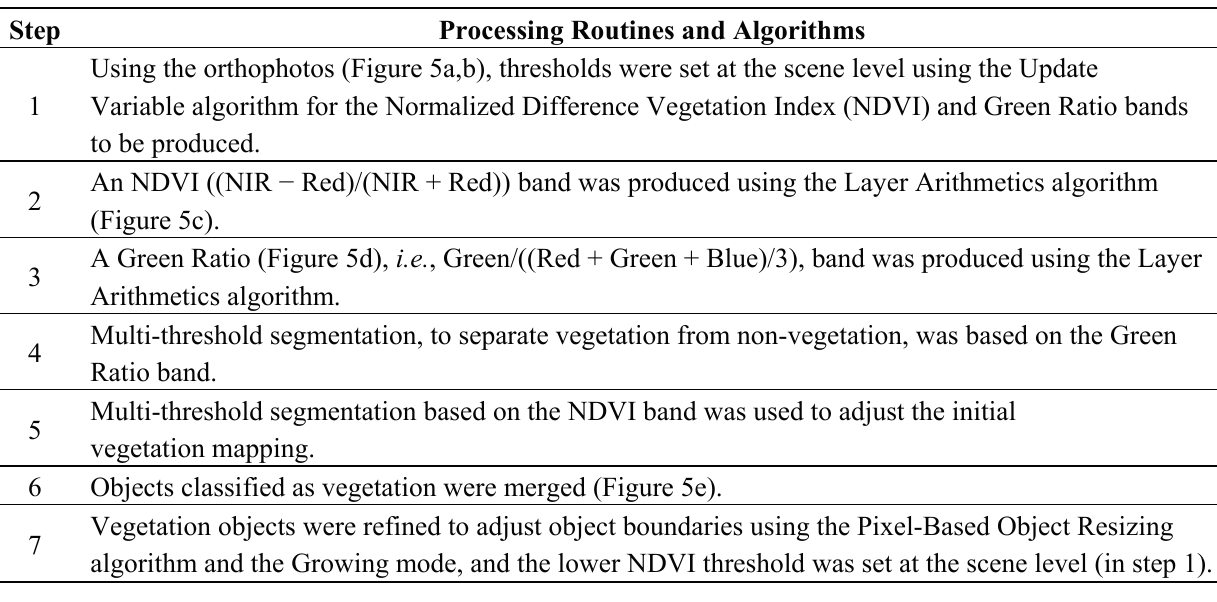
Table 1. Processing routines and algorithms used for mapping vegetation